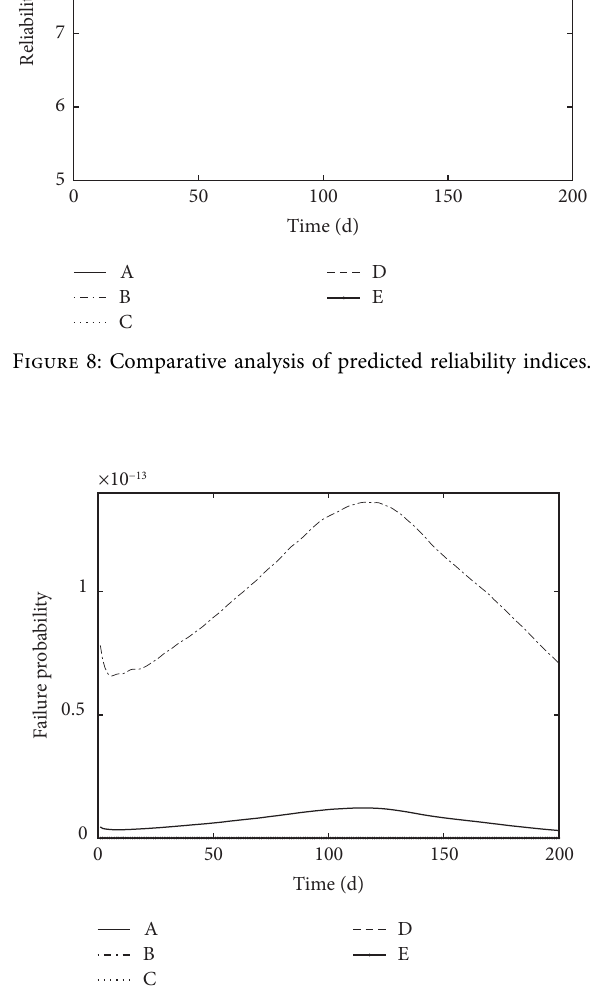
Figure 9: Comparative analysis of predicted failure